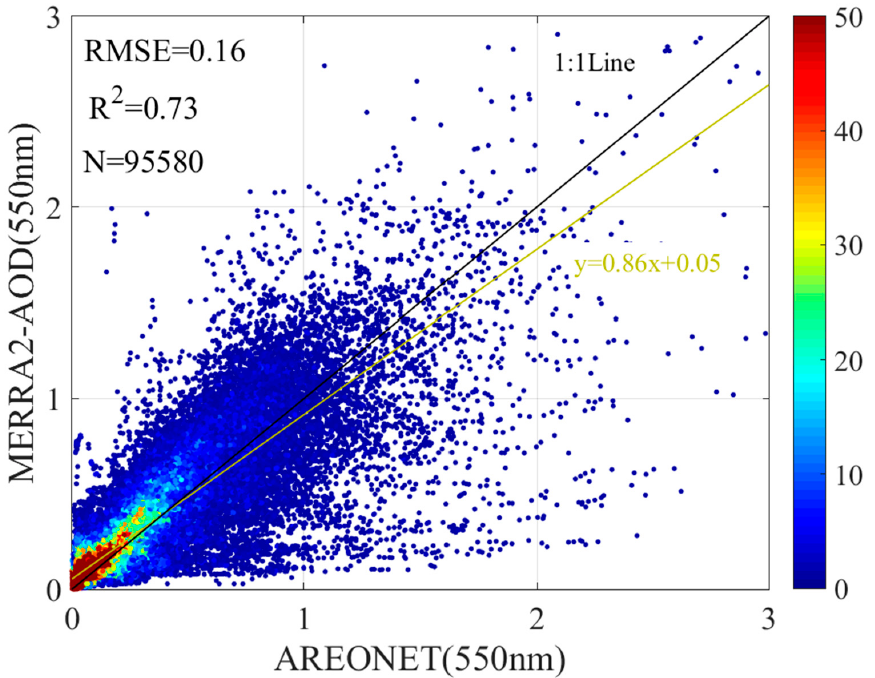
Figure 4. Comparison of AERONET AOD and MERRA-2 AOD from 2010 to 2020.